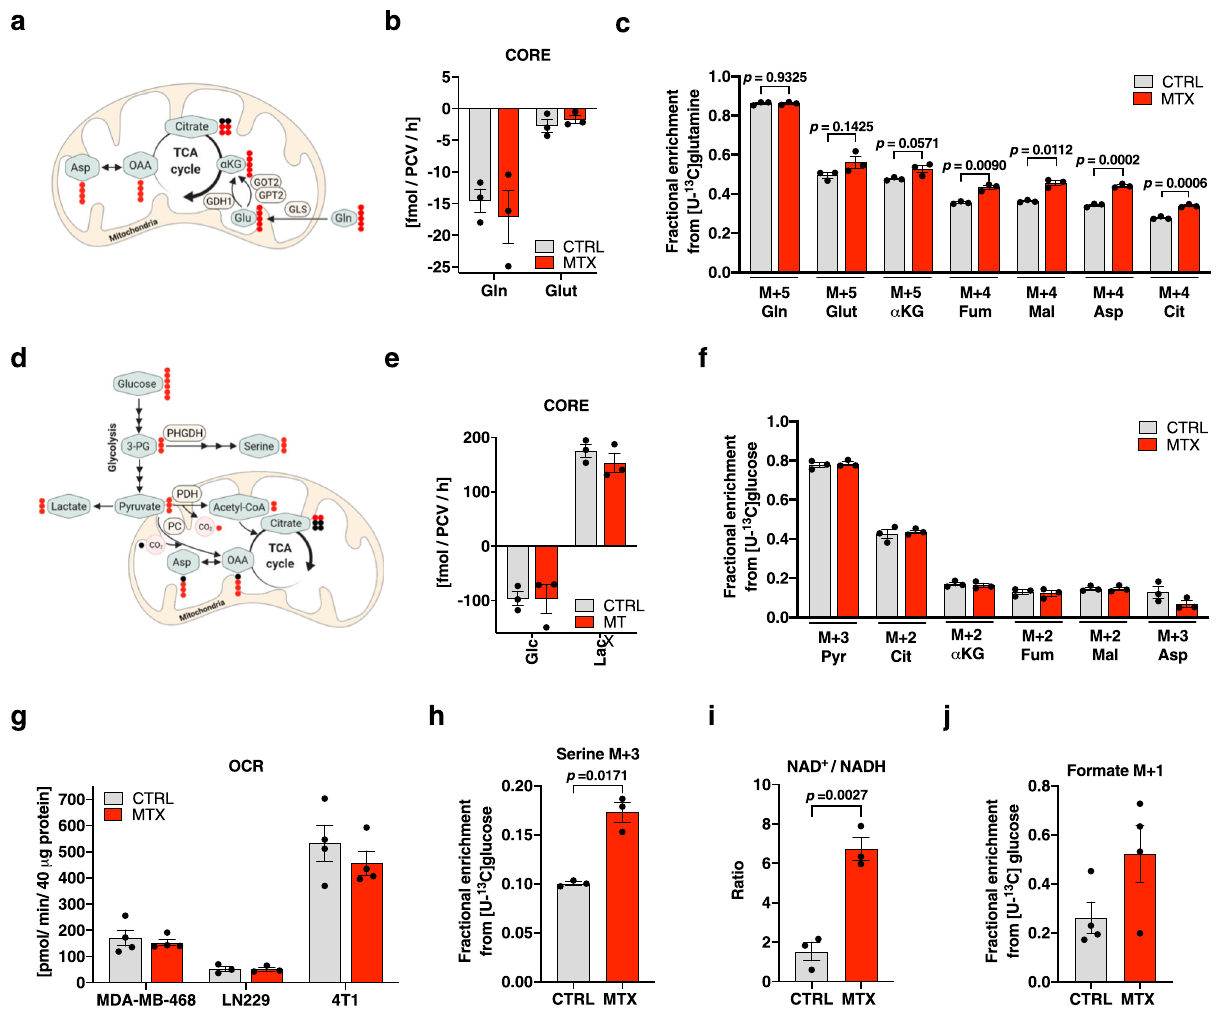
Fig. 3 MTX-treated cells sustain high metabolic rates and enhance de novo serine synthesis. a Interdependence of glycolysis and tricarboxylic acid (TCA) cycle and metabolic 13 C label pattern from [U- 13 C]glutamine. b Absolute consumption and release (CORE) rates of glutamine (Gln) and glutamate (Glut) in the culture medium of MDA-MB-468 cells after 24 h 50 nM MTX. Dots represent the mean of an individual experiments composed of triplicate wells; mean ± SEM ( n = 3). c Enrichment of selected isotopologues of Gln, Glut, α -ketoglutarate ( α KG), fumarate (Fum), malate (Mal), aspartate (Asp), and citrate (Cit) upon [U- 13 C]glutamine tracer in response to 24 h 50 nM MTX in MDA-MB-468 cells. Dots represent the mean of an independent experiments in triplicate wells; mean ± SEM; unpaired, two-tailed t -test with Welch ’ s correction ( n = 3). d Interdependence of glycolysis and TCA cycle and metabolic 13 C label pattern from [U- 13 C]glucose. e Absolute CORE rates of lactate and glucose in the culture medium of MDA-MB-468 cells after 24 h 50 nM MTX. Dots represent the mean of an individual experiments composed of triplicate wells; mean ± SEM ( n = 3). f Enrichment of selcted isotopologues of pyruvate (Pyr), Cit, α KG, Fum, Mal, and Asp upon [U- 13 C]glucose tracer in response to 24 h 50 nM MTX in MDA-MB-468 cells. Dots represent the mean of an individual experiments composed of triplicate wells; mean ± SEM; unpaired t -test with Welch ’ s correction ( n = 3). g Basal cellular respiration upon 24 h 50 nM MTX in MDA-MB-468, LN229, and 4T1 cells as quanti fi cation of mitochondrial oxygen consumption rate (OCR). Dots represent the mean of an individual experiments composed of six technical replicates; mean ± SEM ( n = 3 (LN229), 4 (MDA-MB-468, 4T1)). h Enrichment of M + 3 isotopologue of serine upon [U- 13 C]glucose upon 24 h 50 nM MTX in MDA-MB-468 cells. Dots represent the mean of an independent experiments in triplicate wells; mean ± SEM; unpaired, two-tailed t -test with Welch ’ s correction ( n = 3). i Ratio of absolute intracellular NAD + to NADH in MDA-MB-468 cells upon 24 h 50 nM MTX. Dots represents the mean of an individual experiments composed of triplicate wells; mean ± SEM; unpaired t - test with Welch ’ s correction ( n = 3). j M + 1 isotopologue of extracellular formate in MDA-MB-468 cells from [U- 13 C]glucose upon 24 h 50 nM MTX. Dots indicate the mean of an independent experiments measured in triplicate wells; mean ± SEM ( n = 4). Source data are provided as a Source Data fi